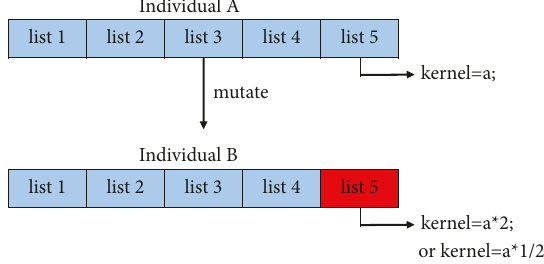
Figure 11: Schematic diagram of parameter mutation of ECNN.